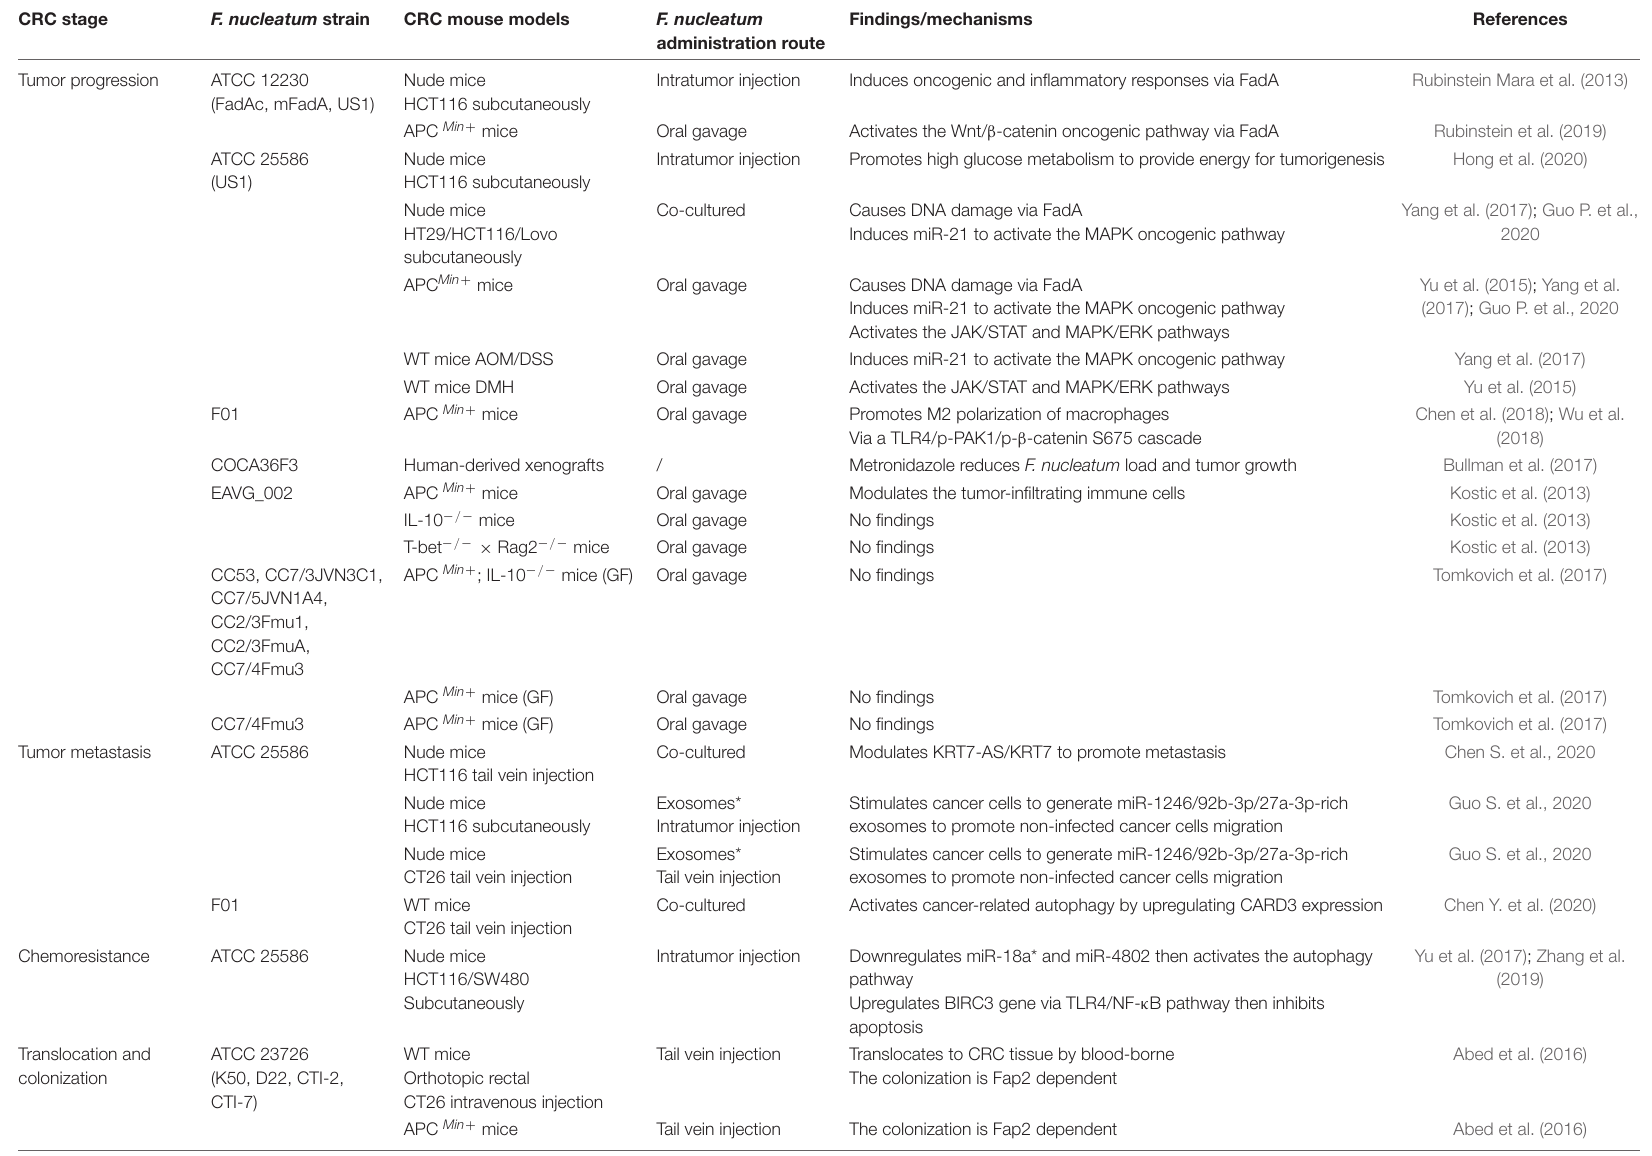
TABLE 2 | Etiological studies of F. nucleatum in CRC mouse